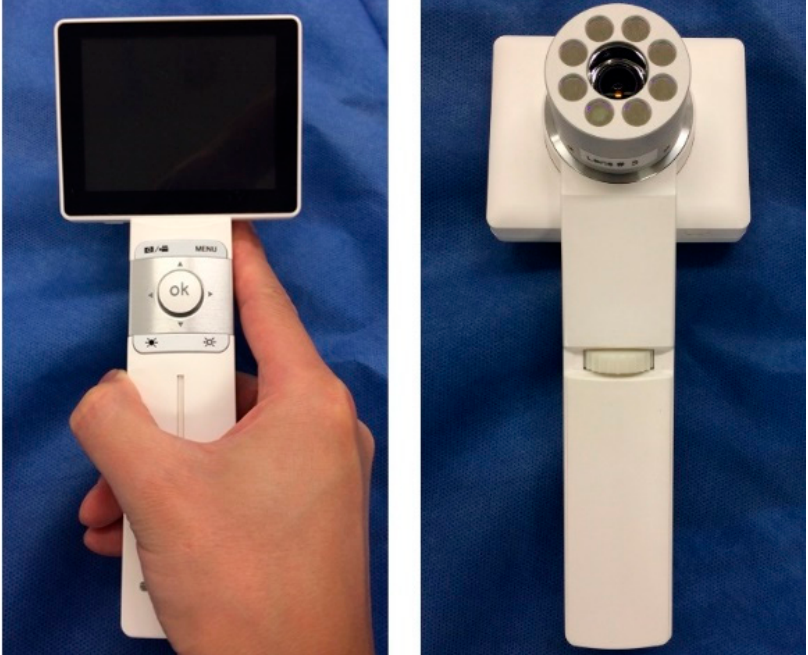
Figure 1. Novel handheld camera device for 5-aminolevulinic acid photodynamic diagnosis (ALA-PDD).